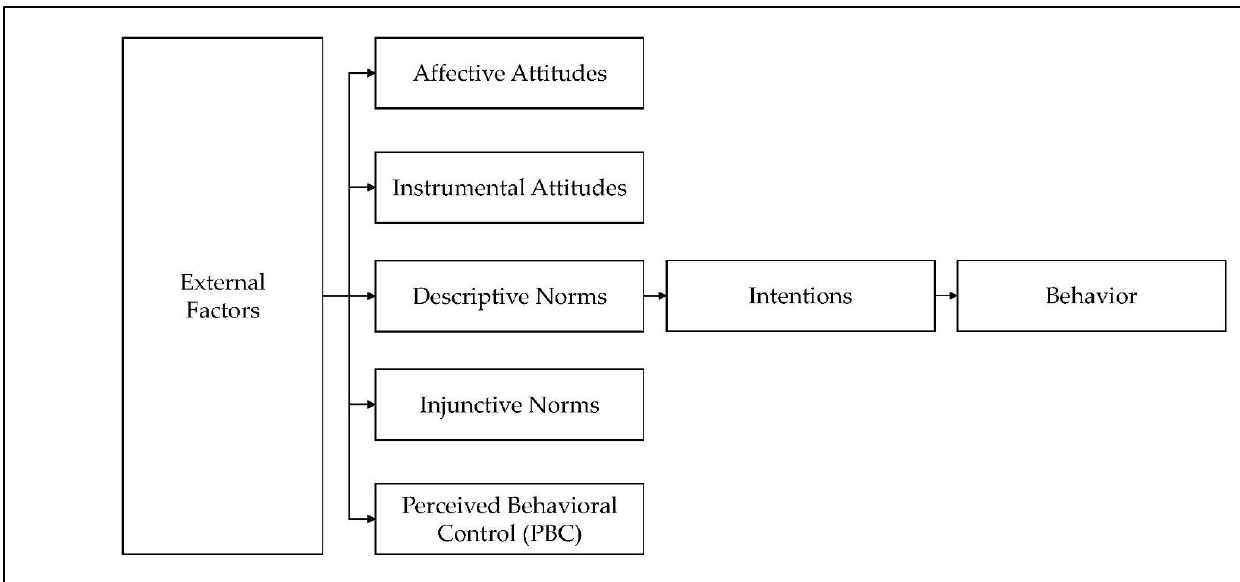
Figure 1. Adaption of Ajzen’s Theory of Planned Behavior (TPB). 2011.